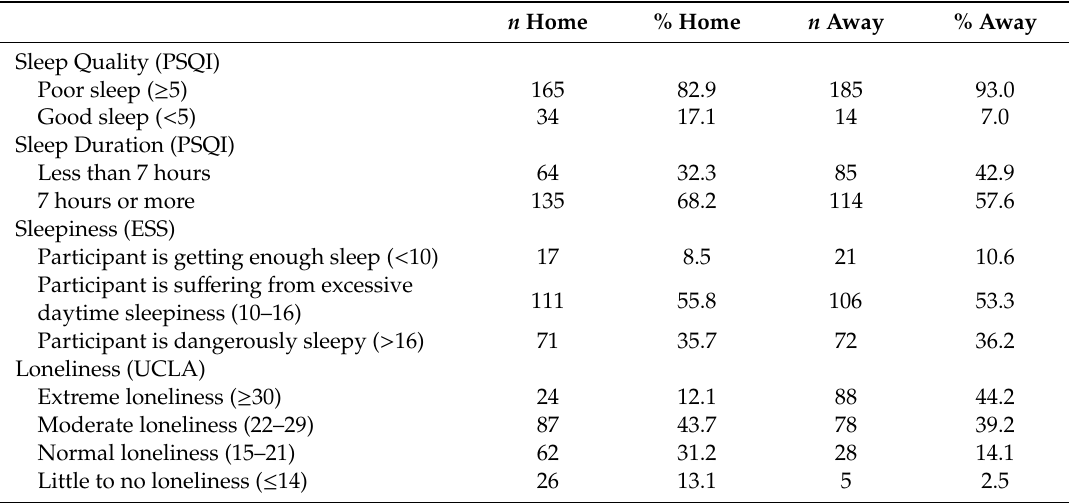
Table 1. FIFO / DIDO Partners’ Sleep Quality, Sleep Duration, Sleepiness, and